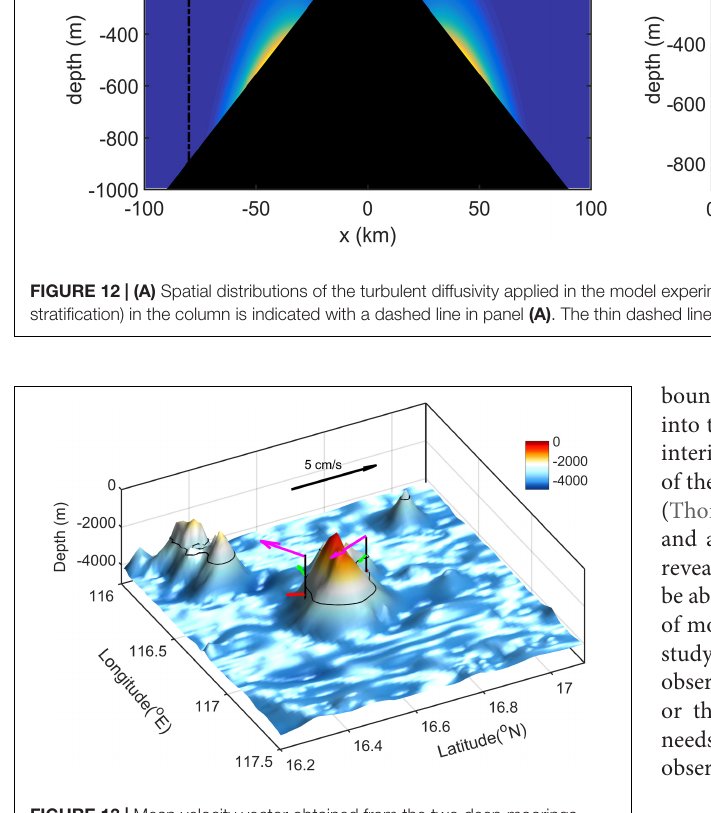
FIGURE 13 | Mean velocity vector obtained from the two deep moorings located on the slope of the seamount in the SCS. The arrows with different colors indicate the mean velocity vector of different depth, and the black lines represent the 3,000-m